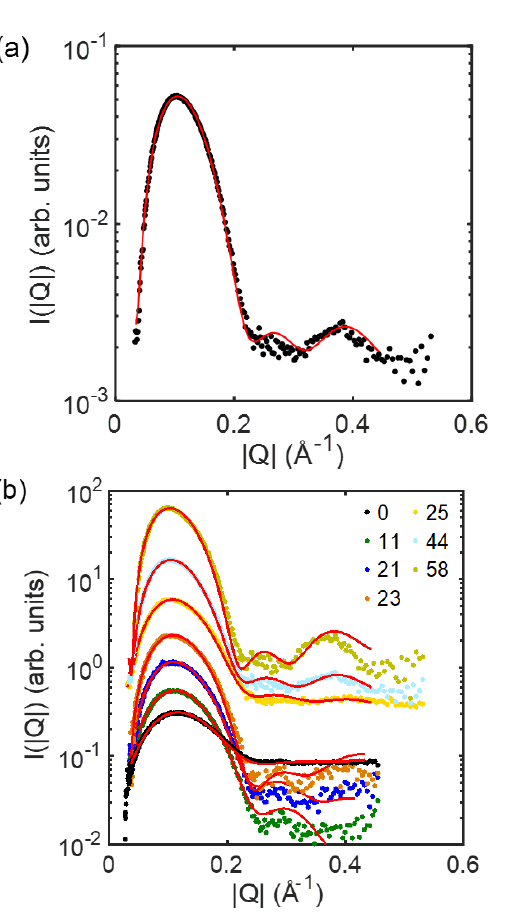
(cid:18)(cid:12) (cid:12) (cid:12) (cid:12) (cid:12)(cid:19) → → (cid:12) (cid:12) (cid:12) (cid:12) Q Q gainst for the ULVs with ( a ) the composition of (cid:12) (cid:12) (cid:12) (cid:12) (cid:12) (cid:12) (cid:12)